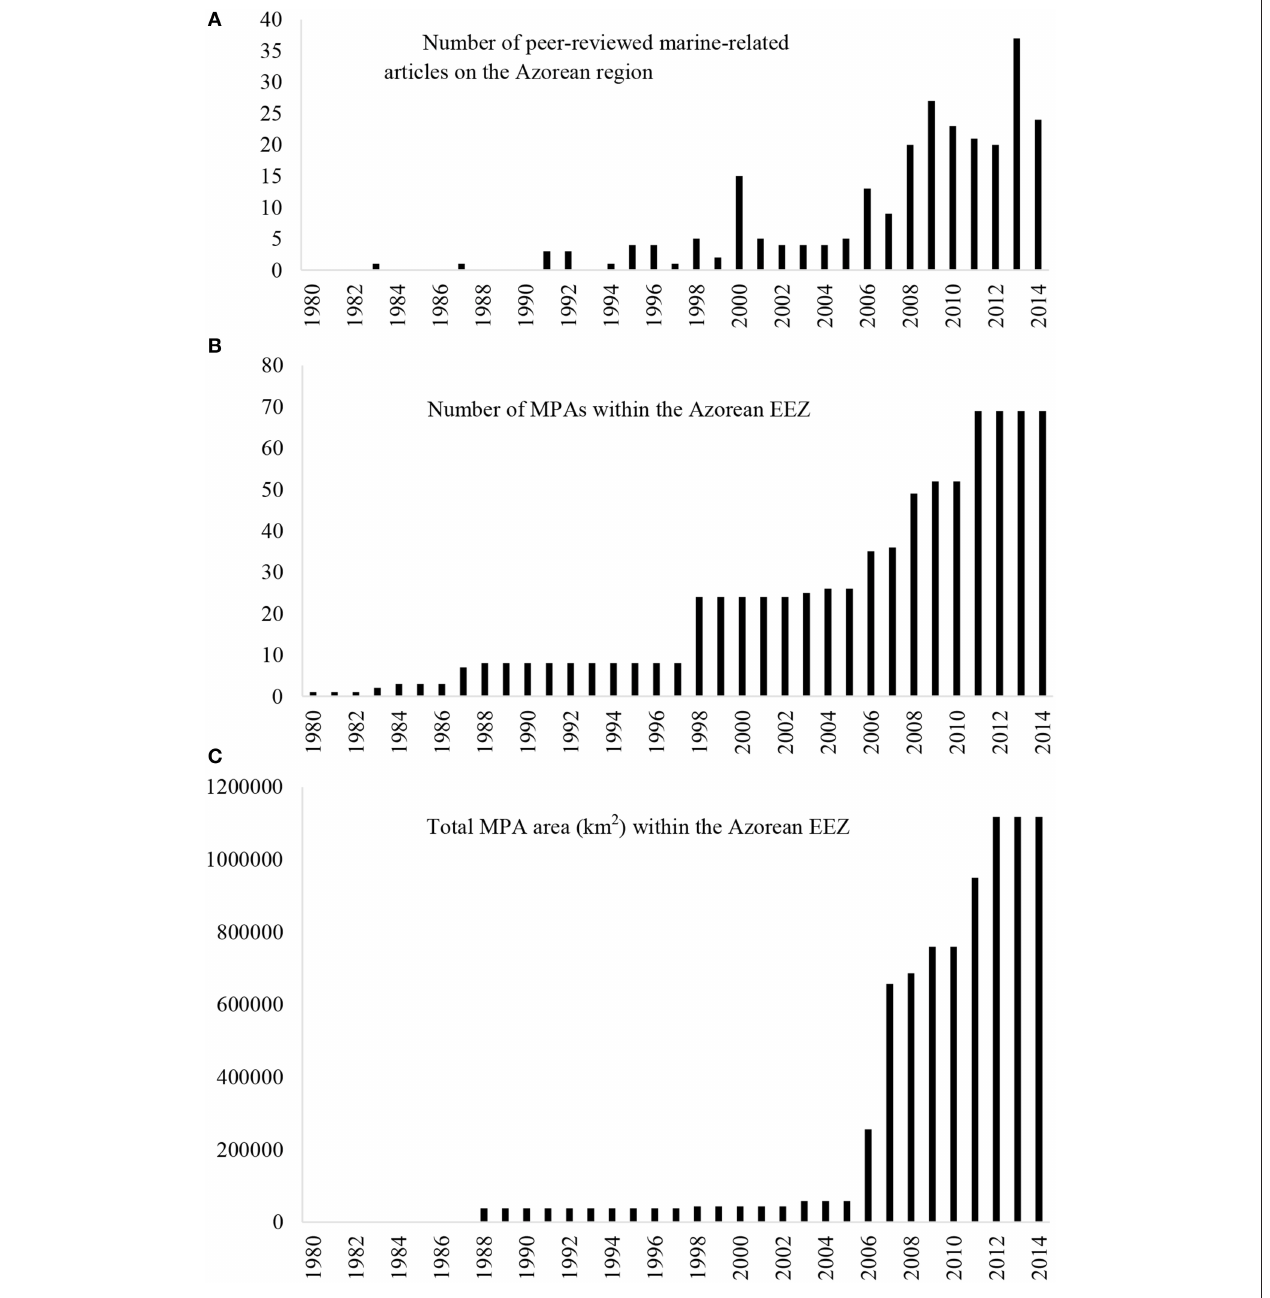
FIGURE 2 | Main marine conservation trends in the Archipelago of the Azores since 1980. (A) number of peer-reviewed scientific articles about the Azorean marine environment published each year; (B) total number of MPAs in force each year within the Azorean Exclusive Economic Zone (EEZ); (C) total MPA area (km 2 ) in force each year within the Azorean